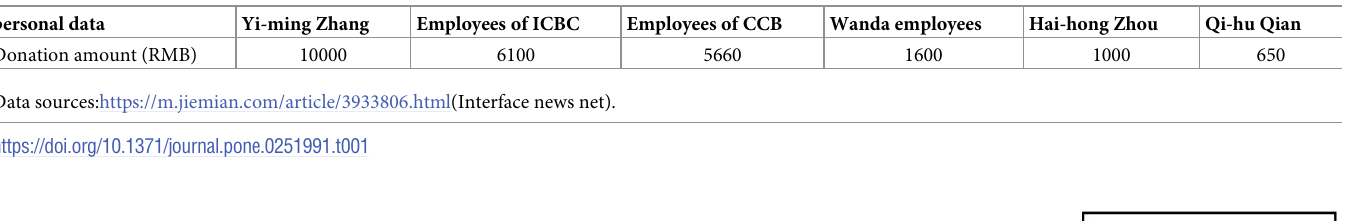
Table 1. Some individual donations in China. Unit: ten thousand